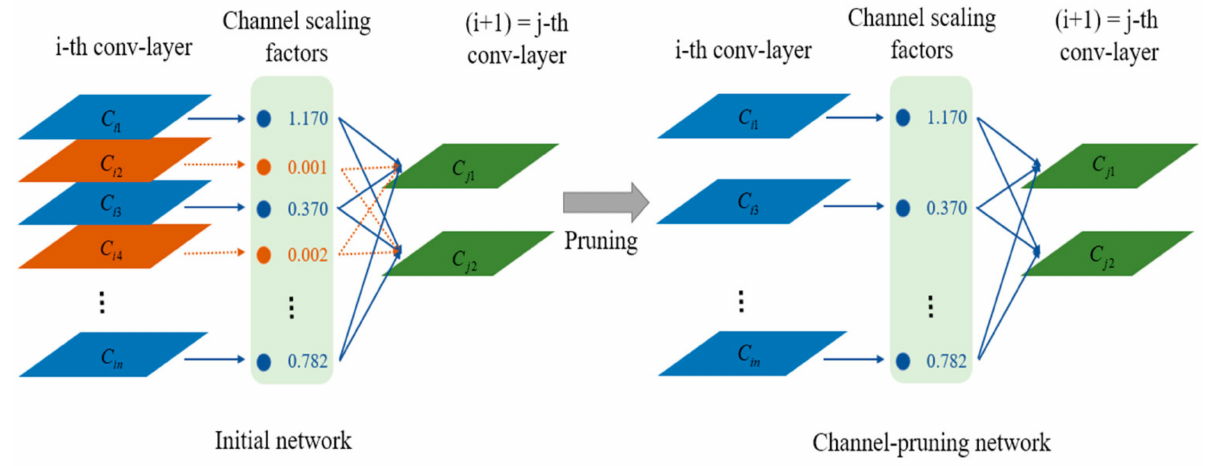
Figure 7. Pruning schematic diagram of the channel pruning